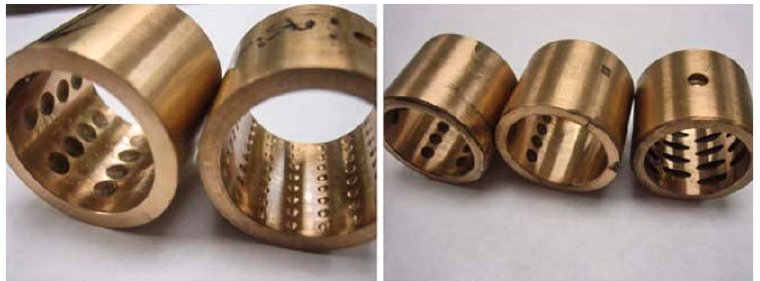
Figure 9. Surface textures of plain bearings. Reprinted with permission from Ref. [60]. 2007, Springer.